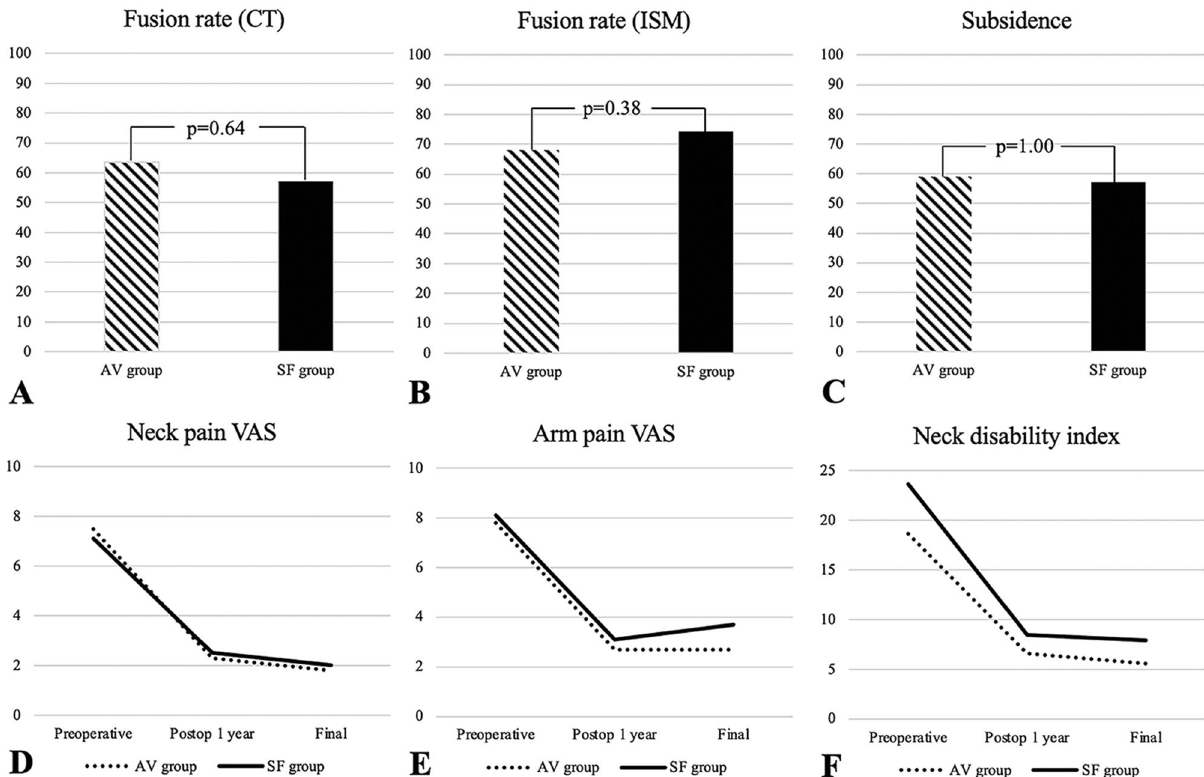
Figure 3. Radiographic results and patient reported outcome measures. ( A ) Fusion rates assessed by bone bridging evaluated on CT. ( B ) Fusion rates assessed by interspinous motion. ( C ) Subsidence rate ( D ). Neck pain visual analogue scale. ( E ) Arm pain visual analogue scale. ( F ) Neck disability